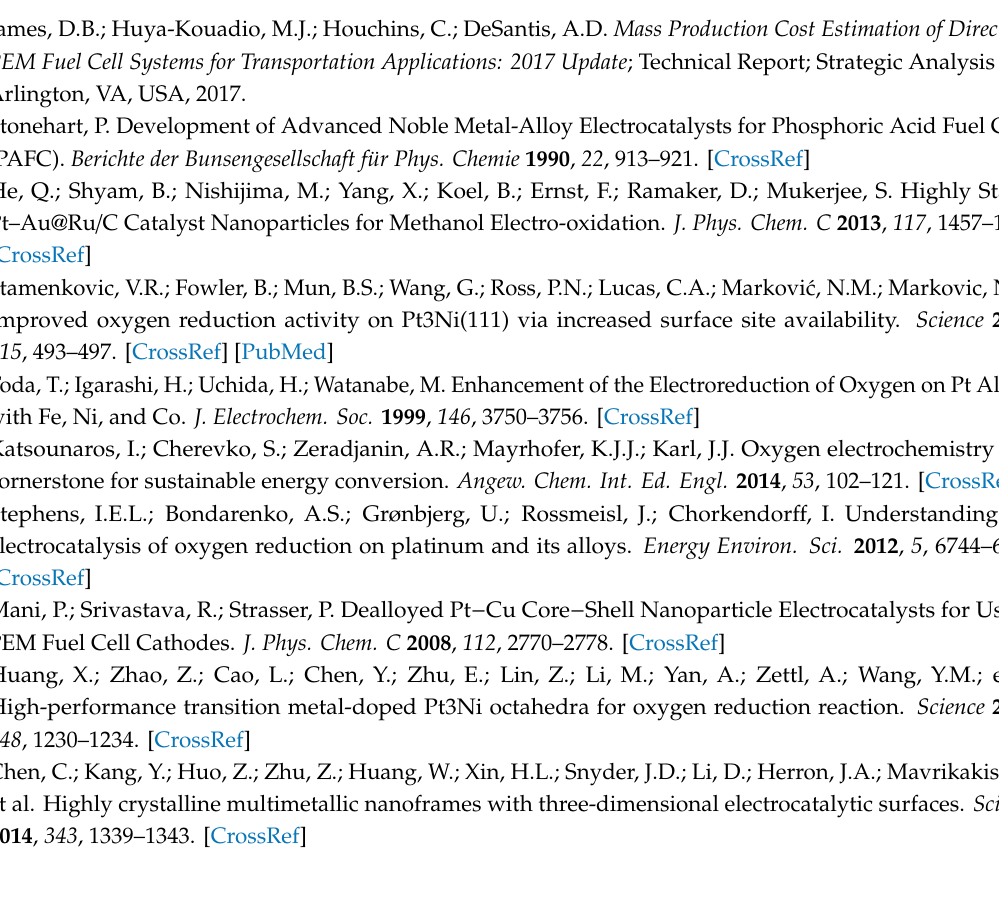
Figure S1: High-resolution STEM micrographs of PtCu 3 nanoparticle, Figure S2: IL-STEM and IL-EDX line scans of PtCu 3 electocatalyst, Figure S3: SEM image-e ff ect of milling, Figure S4: Experimental and modeled impedance spectra, Table S1: ICP-MS data, Table S2: TF-RDE results, Table S3: Parameters in the model of